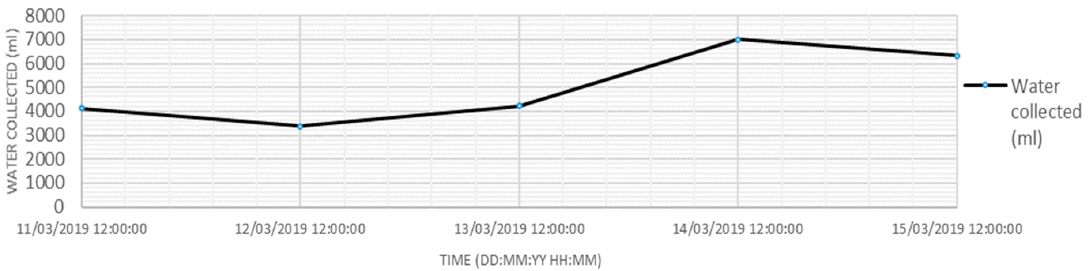
Figure 11. The amount of water collected by solar still in the second week.